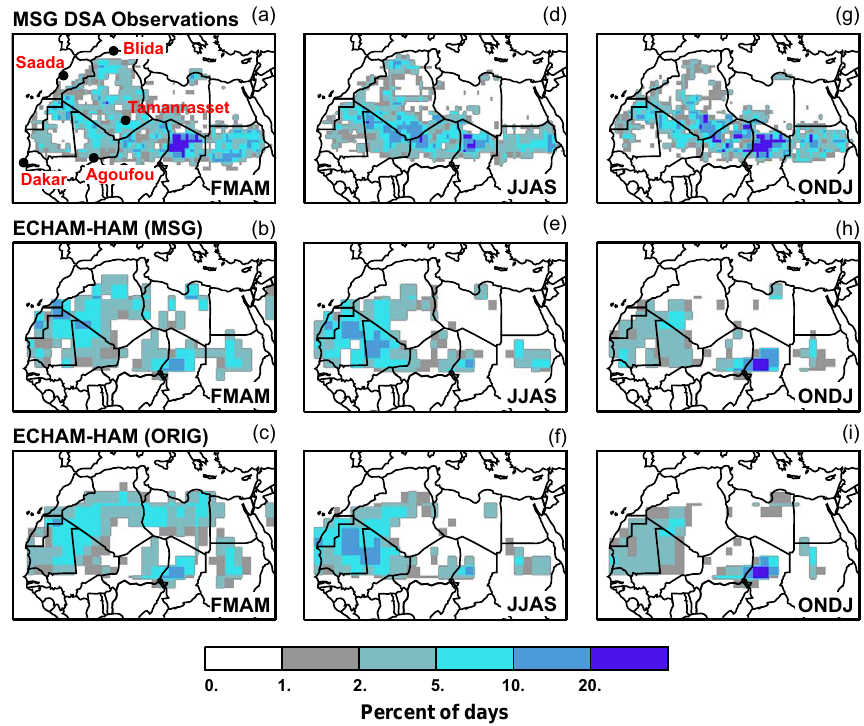
Figure 3. Saharan dust source activations in percent of days as (a, d, g) derived from MSG-SEVIRI dust index imagery and computed by ECHAM-HAM using (b, e, h) the MSG-based source mask and (c, f, i) the original map of preferential dust sources. Shown are average values for the years 2007 and 2008, averaged for the months (a–c) February to May, (d–f) June to September, and (g–i) October to January. Black dots in (a) indicate the location of AERONET stations used for model